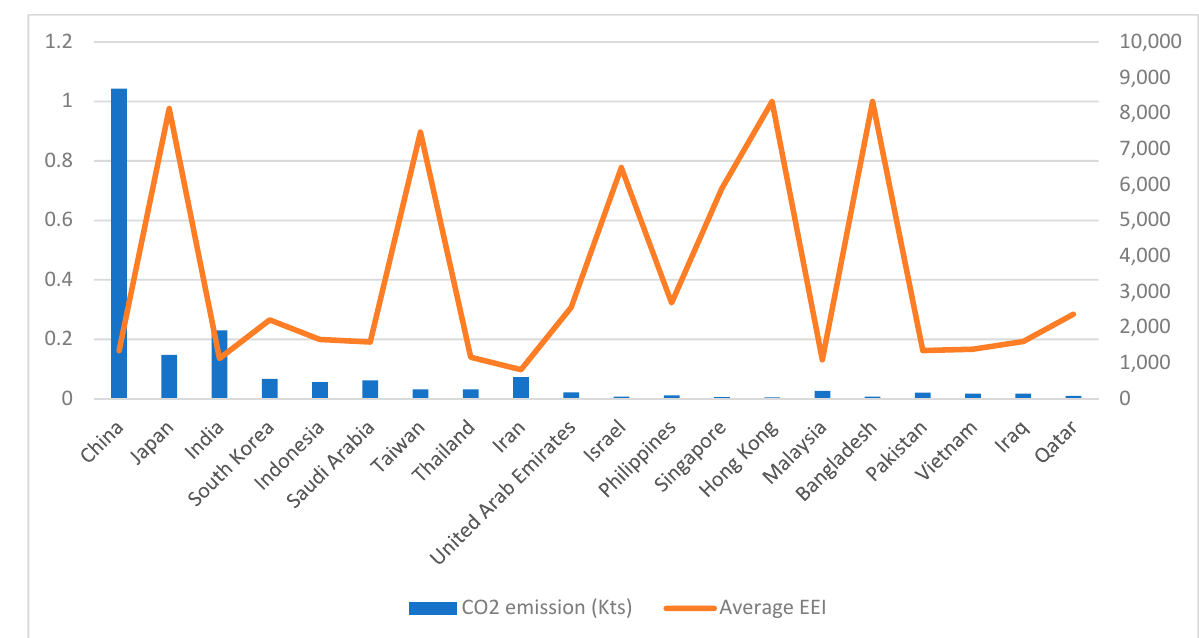
Figure 6. Comparison between the average EEI and the Average CO 2 Emission. Source: authors’ estimation.